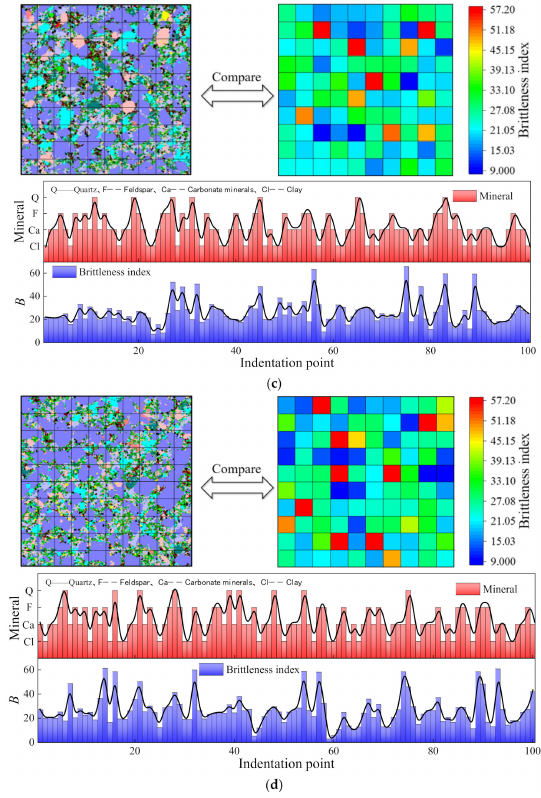
Figure 13. The relationship between brittleness index and minerals: ( a ) nanoindentation grid 1, ( b ) nanoindentation grid 2, ( c ) nanoindentation grid 3, ( d ) nanoindentation grid